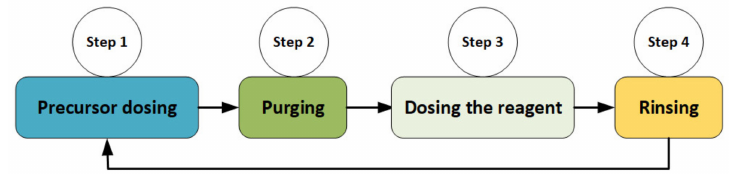
Figure 5. ALD cycle